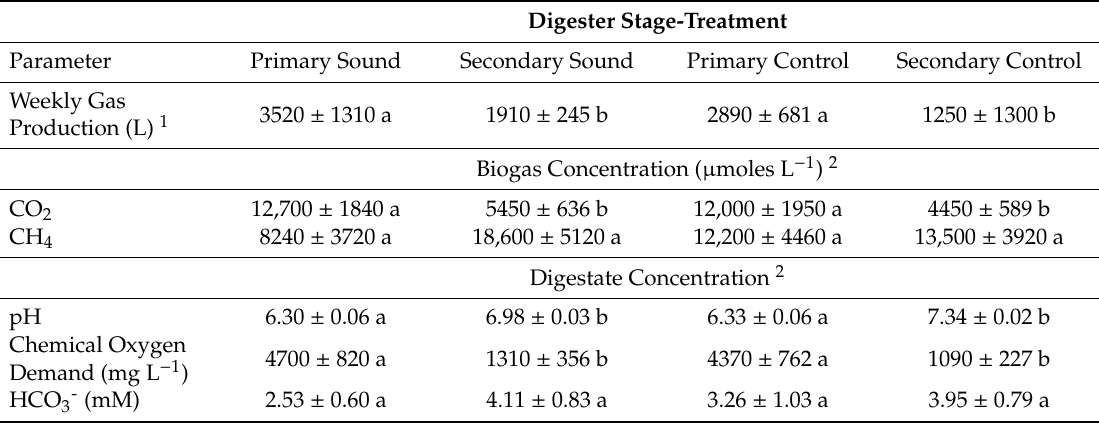
Table 1. Biogas production and quality and selected wastewater quality parameters during the initial evaluation period from April 10 through July